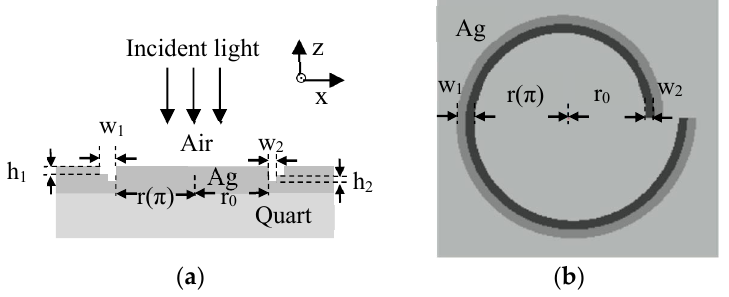
Figure 1. Schematic view for ( a ) the cross-section and ( b ) the top view of the surface plasmonic lens. The primary spiral slot can be regarded as a subwavelength MIM gap waveguide.